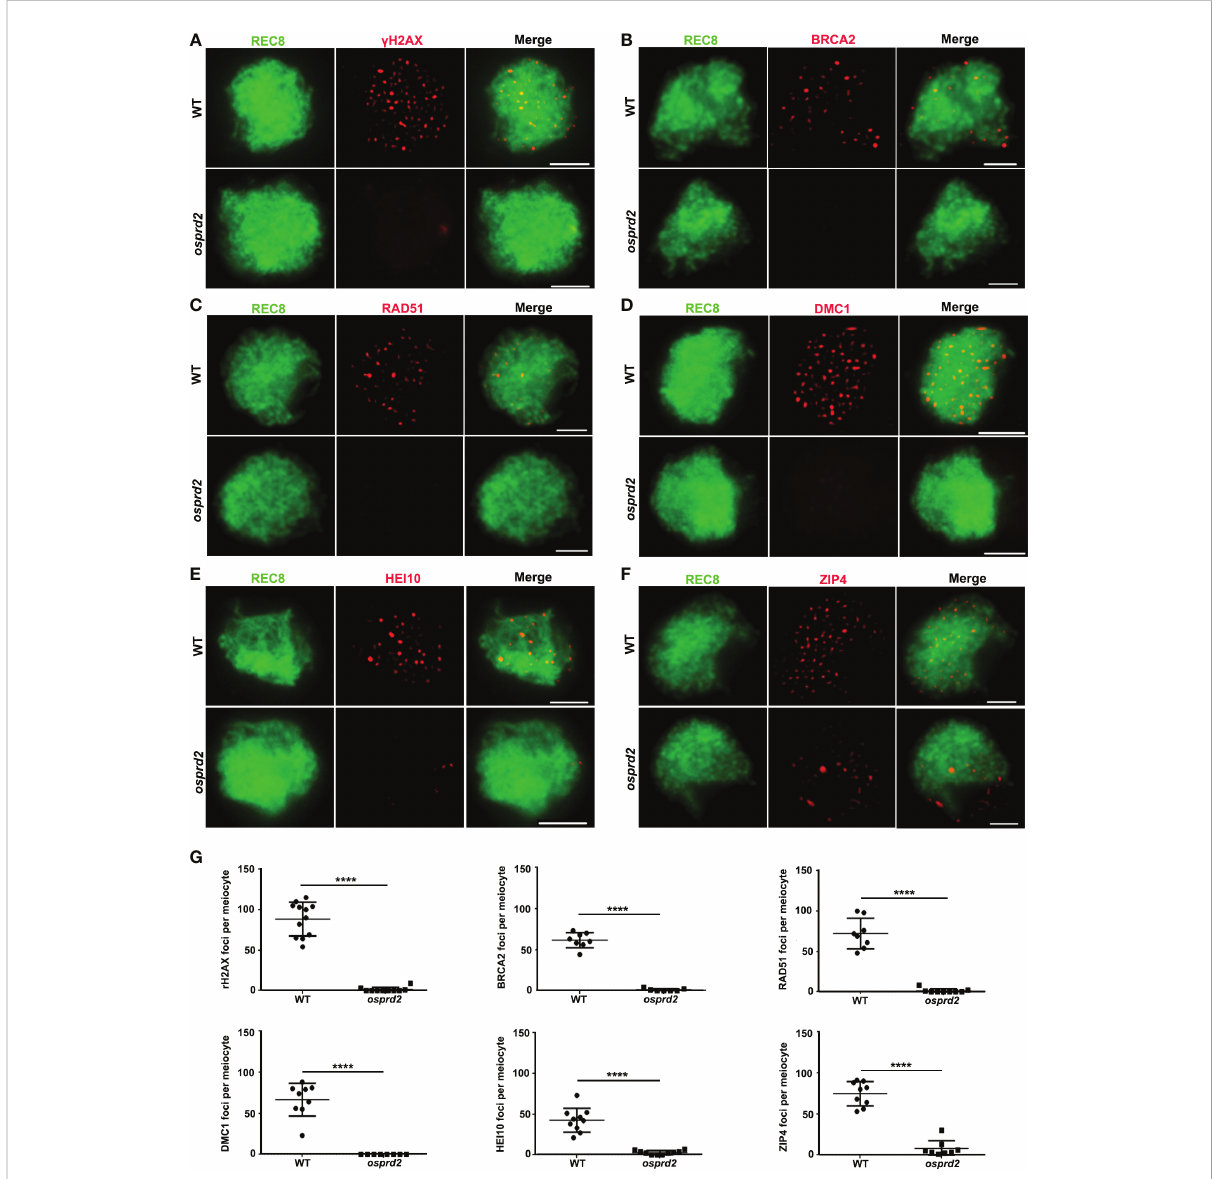
FIGURE 3 Immunostaining detection of homologous recombination related proteins in the WT and osprd2 mutant. (A) is g H2AX signals (red) at zygotene; (B) is BRCA2 signal (red) at zygotene; (C) is RAD51 signals (red) at zygotene; (D) is DMC1 signals (red) at zygotene; (E) is HEI10 signals (red) at zygotene; (F) is ZIP4 signals (red) at zygotene; OsREC8 signals (green) were used to indicate the meiotic chromosome axes; (G) Statistical analysis of the number of g H2AX, BRCA2, RAD51, DMC1, HEI10 and ZIP4 foci per meiocyte in the wild type and osprd2 . error bars indicate SD, ****p < 0.0001, t tests. Bar=2 m